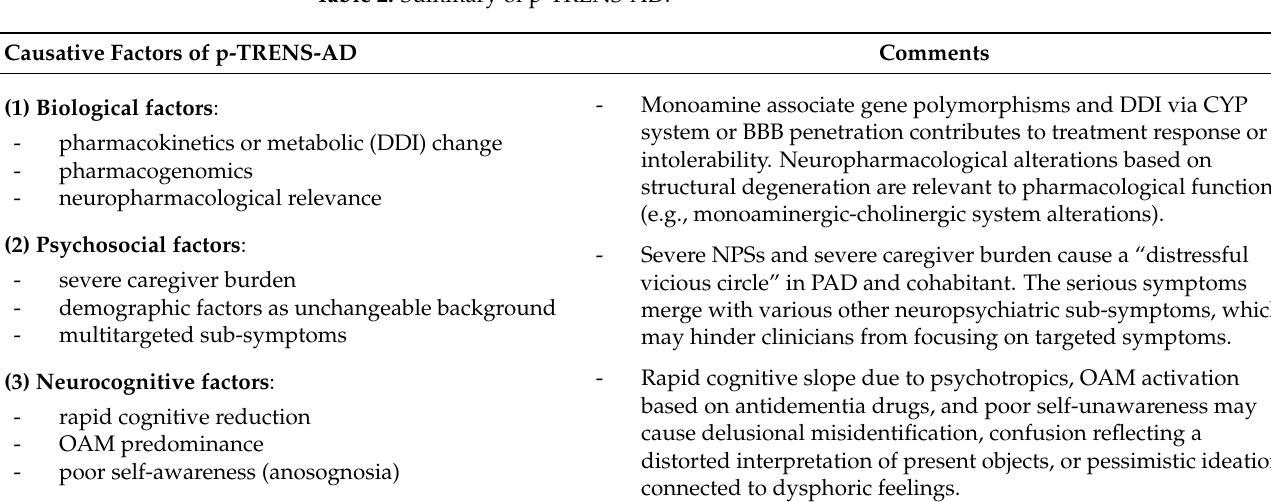
Table 2. Summary of